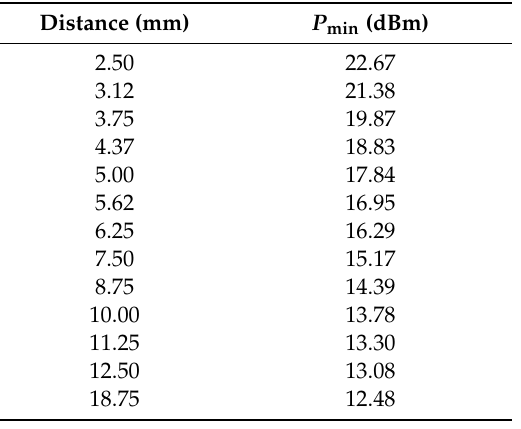
Table 8. Tag-to-meat distance factor e ff ects. The mean values of the minimum power needed to activate the tag ( P min (dBm)) are reported for each tag-to-meat distance in the range 2.50–18.75 mm.